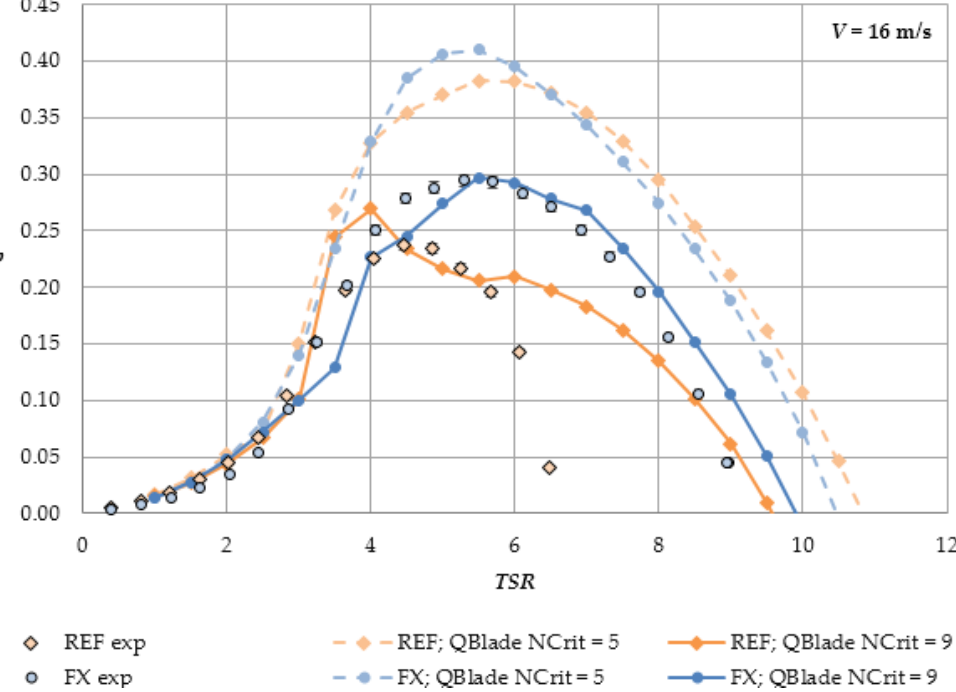
Figure 11. Results of the experiment compared to the numerical predictions for the scaled models at the wind speed of 16 m/s; measurement uncertainty included.